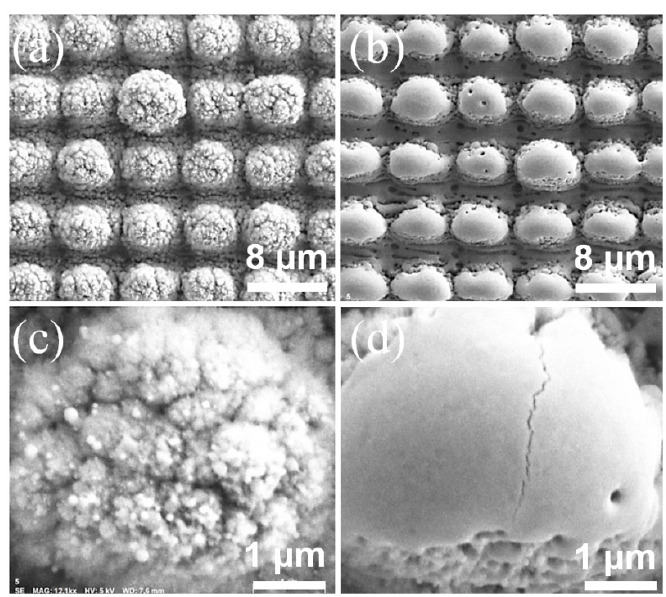
Figure 6. SEM images of stainless steel samples processed by ps-DLIP with pillar-like topographies, ( a,c ) multi-scale structures and ( b,d ) single-scale structures after the ns laser treatment (at 0.27 J/cm²). Figures ( c ) and ( d ) show a high magnification image corresponding to the top of each pillar. Table 1. Chemical composition C, O, Fe and Cr elements (at. %) for the multi-scale structures (ps-DLIP) and single-scale (ps-DLIP + ns) treated surfaces (corresponding to Figure 6) measured by EDX. Sample C (at. %) O (at. %) Fe (at. %) Cr (at.%)